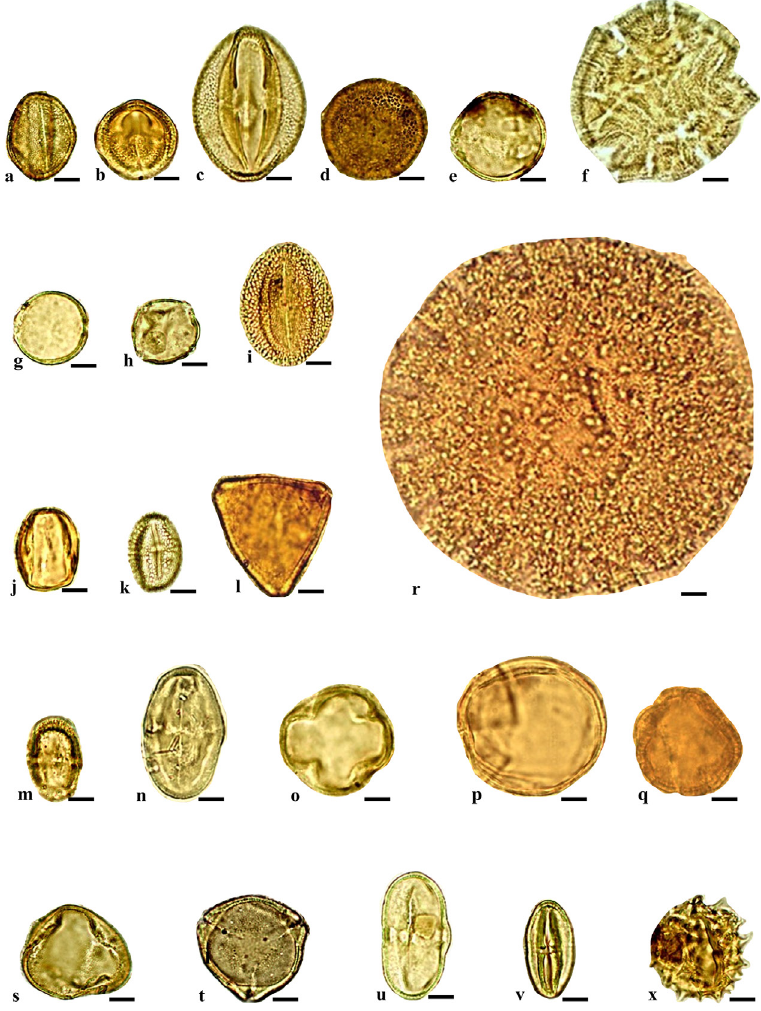
Figure 4. Euphorbiaceae Type